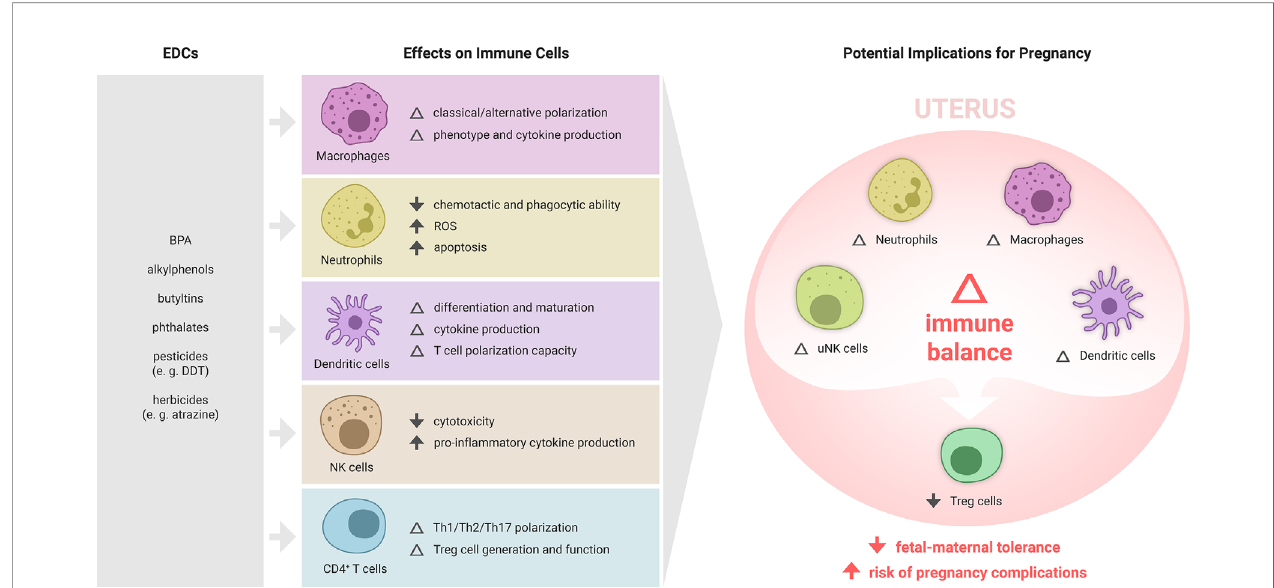
FIGURE 2 | Summary of EDC effects on immune cell subsets and potential implications for maternal immune adaptation to pregnancy. Various EDCs affect the differentiation, phenotype and function of speci fi c immune cell subsets, each of which play important roles in maternal immune adaptation to pregnancy. While the effects of EDCs on the immune response to pregnancy are yet to be formally examined, there is substantial evidence from other settings showing that various ECs can modulate macrophages, T cells, NK cells, and dendritic cells. In particular, EDCs that impair the generation of regulatory T cells (Treg cells), key mediators of fetal-maternal tolerance that are essential for embryo implantation and placental development, are likely to elevate susceptibility to pregnancy complications, and warrant investigation as contributing risk factors in recurrent miscarriage, preeclampsia, preterm birth and related gestational